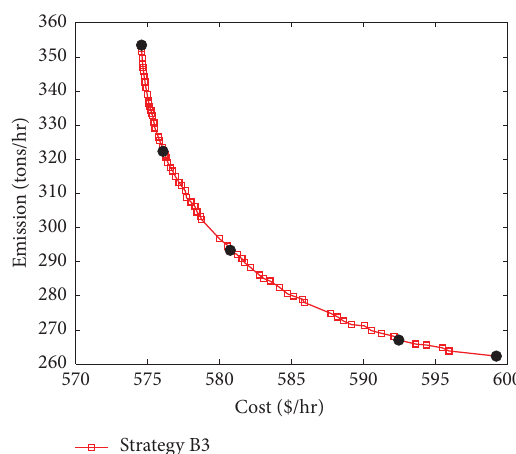
Figure 9: Pareto-optimal front for strategy B